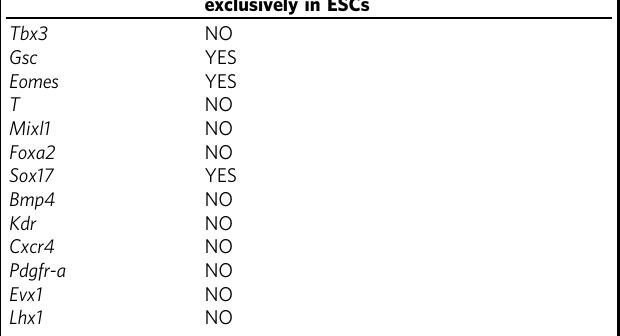
Table 1 Pluripotency enhancer-associated lncRNA loci distal to ME